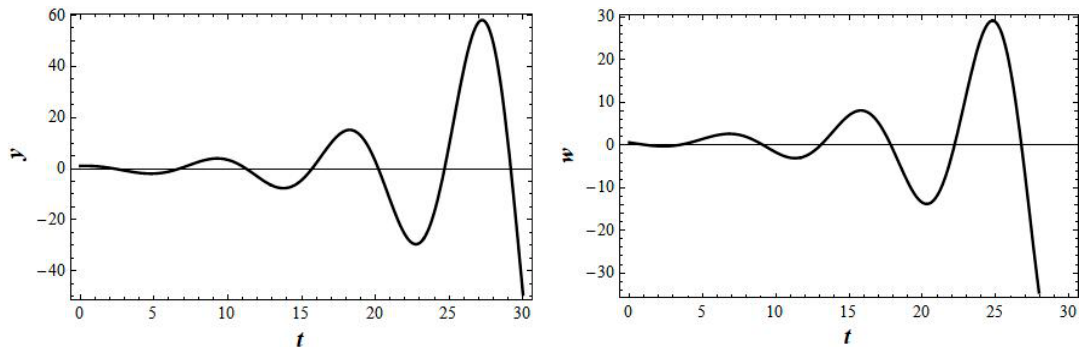
Figure A5. Exact solutions of system (2) when b 1 = − 1.942, b 2 = 1, b 3 = 1.064, b 4 = − 2, k = 1, c 1 = 1, according to Formula (16).